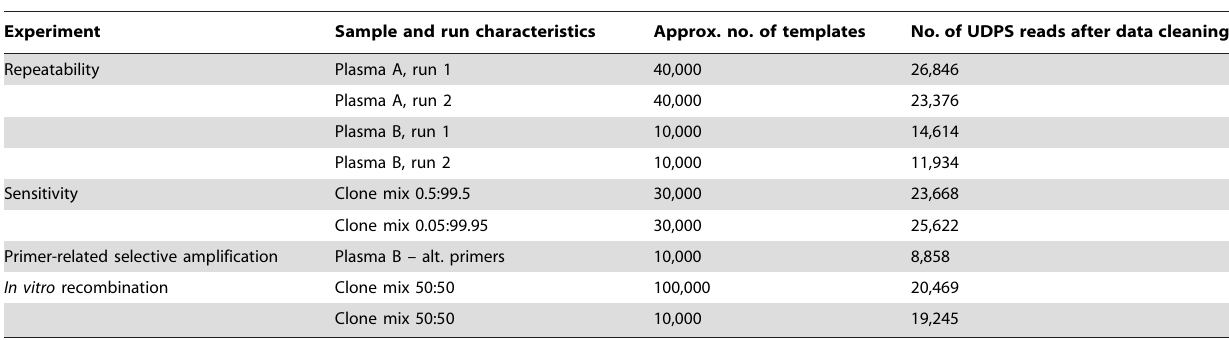
Table 1. Characteristics of the samples and basic information on